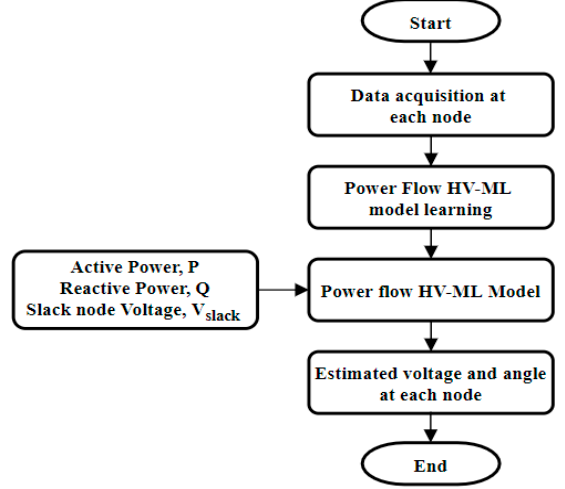
Figure 1. Flow chart of HV-ML Model .